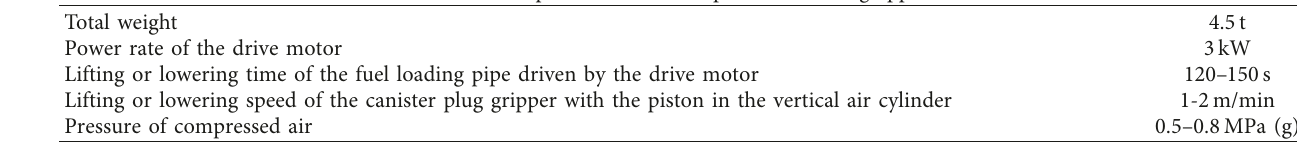
Table 1: Main parameters of the spent fuel loading